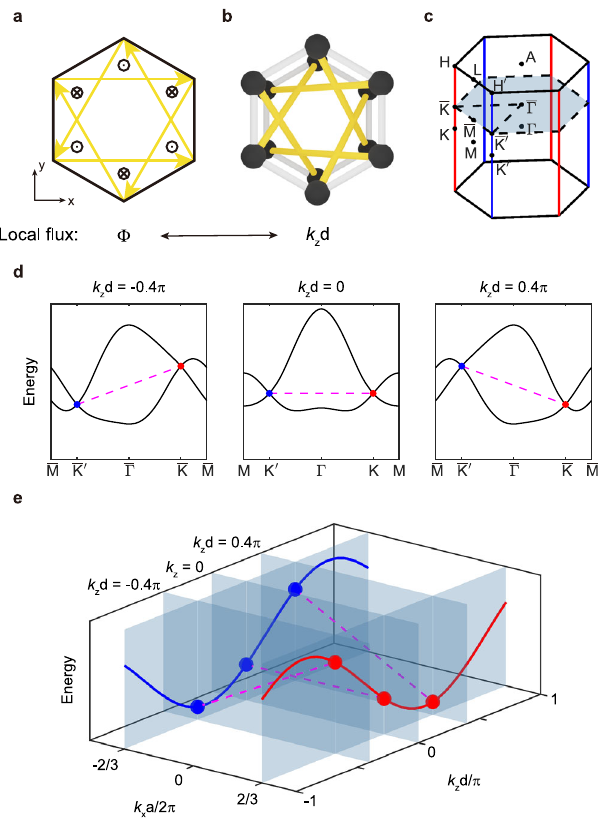
Fig. 1 | Synthetic gauge fl ux in time-reversal system and the resulting energy- offset between Dirac points. a 2D tight-binding model for a modi fi ed Haldane lattice.TheNNNcouplingsarerepresentedbyyellowarrows,resultinginstaggered magnetic fl ux Φ ( “ (cid:4) ” and “ (cid:5) ” ). b 3D tight-binding model for an AA-stacked hon- eycomb lattice. Via dimension reduction, the interlayer couplings (yellow sticks) mimicnonreciprocalNNNcouplingsasinanMHM.Inthereduced2Dsystemwitha fl ux is proportional to k fi rst fi xed k z , the effective staggered magnetic z d . c The Brillouin zone of the 3D hexagonal lattice. A 2D cut plane with a speci fi ed k z is highlightedbyacyanplane,whichcorrespondstothe2DBZofthereducedsystem. d Bulk band structures on different k z planes. The 2D subsystem hosts two iso- energy Dirac points for the zero k z , whereas it hosts energy-offset Dirac points for nonzero k z . e ANLson (cid:2) HHand (cid:2) H 0 H 0